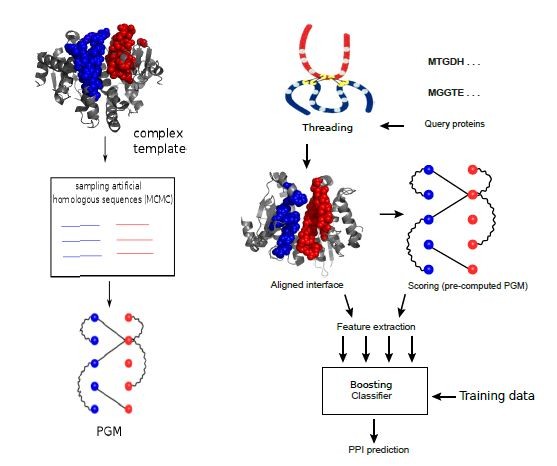
Flowchart of Coev2Net. Left: Markov chain Monte Carlo (MCMC) sampling to generate synthetic homologous sequences for each complex template. Right: 1) for given query protein pairs, the best template (from the structural library) is identified by protein threading; 2) structural and sequence features are extracted from the interfacial alignment and residue correlations scored with respect to the profile PGM; and 3) a classifier gives the probability of interaction for the query protein pair.